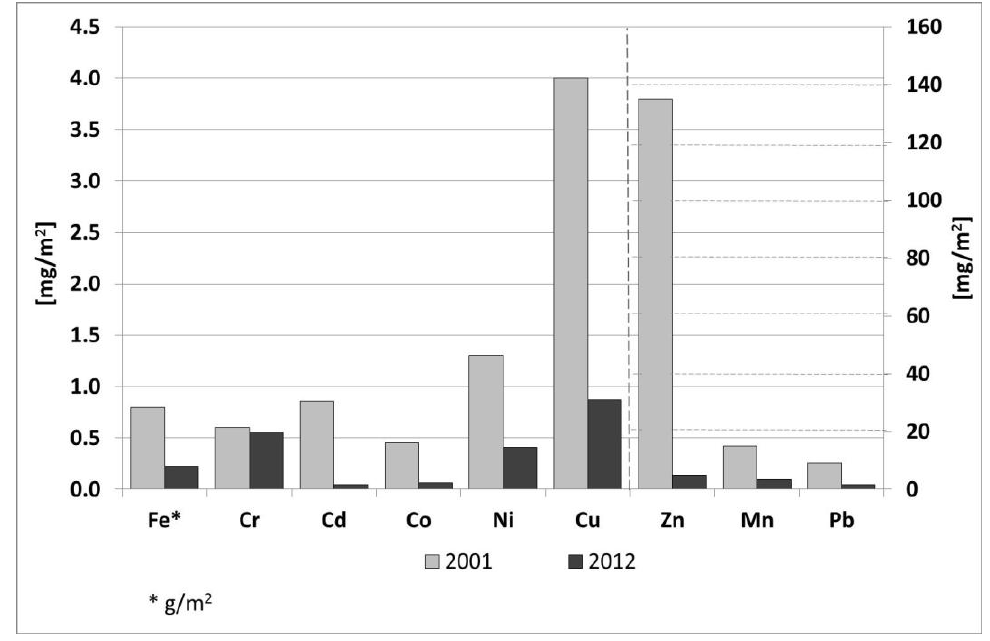
Fig. 13. Mean annual dry deposition values for the selected metals in Goczałkowice in 2001 and 2012 in [mg/m 2 ], Fe* – [g/m 2 ]